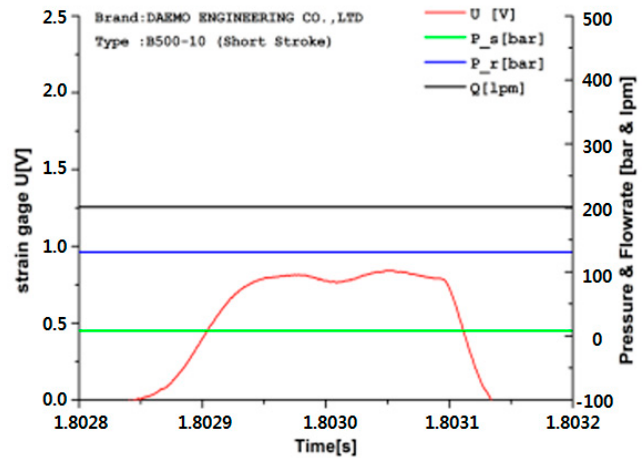
Figure 11. Result graphs of the impact energy (upper: long / lower: short). Table 5. Results of the impact efficiency.